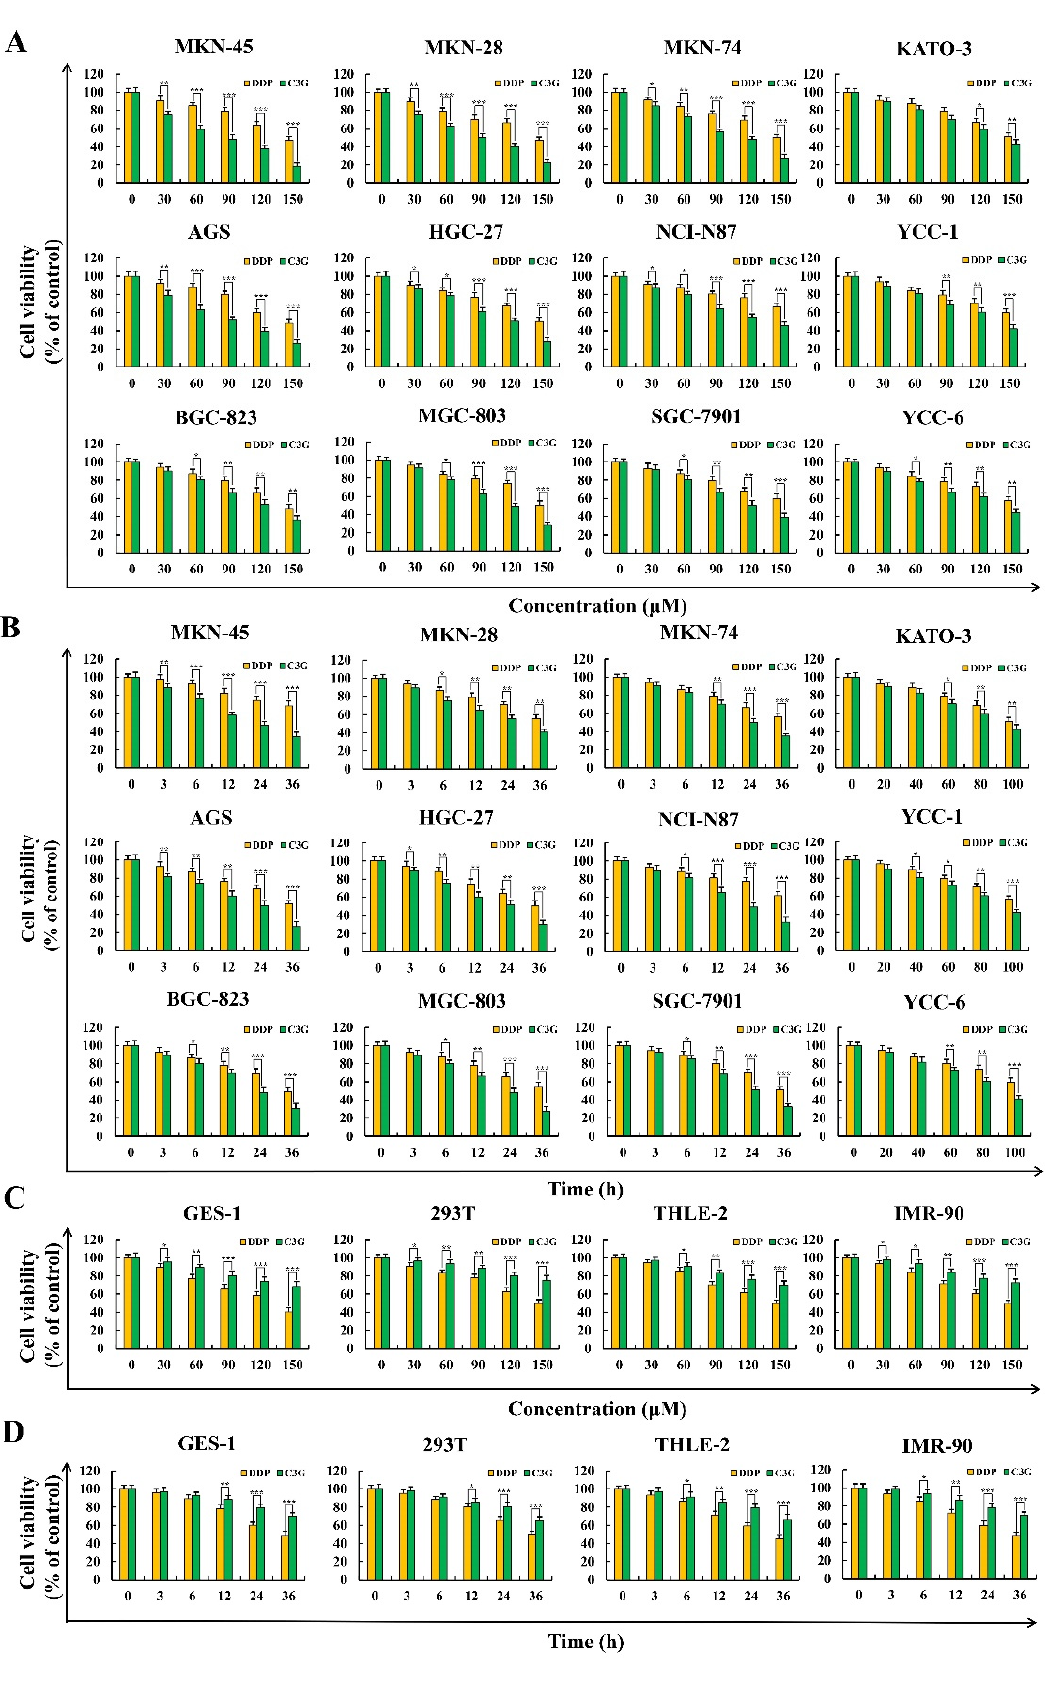
Figure 1. Cytotoxic effects of C3G and DDP were detected using a CCK-8 assay. ( A ) Various concentrations (30, 60, 90, 120, and 150 µ M) of C3G and DDP on the toxicity of 12 human GC cell lines. ( B )